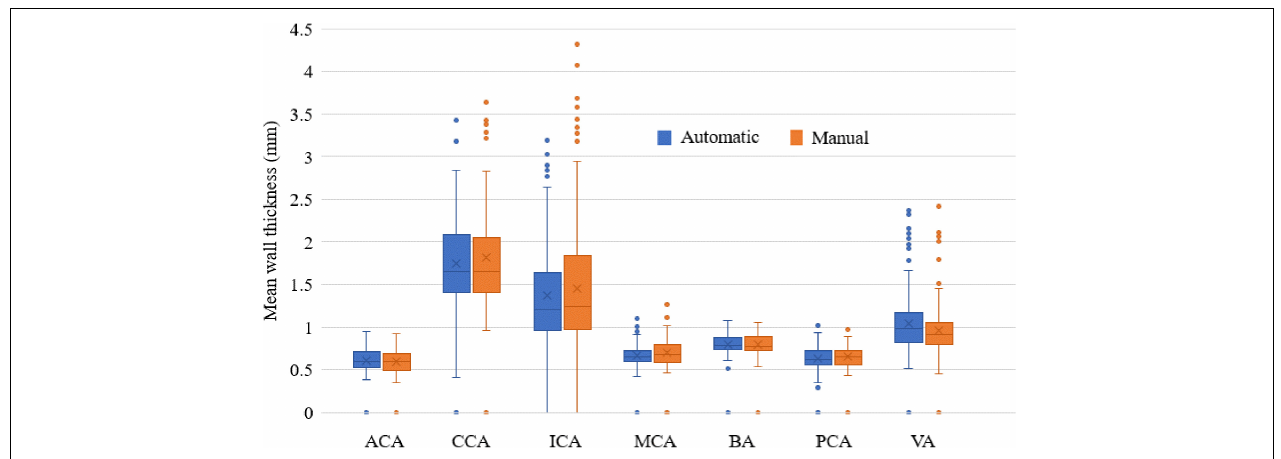
FIGURE 8 | The mean wall thickness of seven arterial segments. Boxplot shows the median with 25th and 75th percentiles. The “ × ” symbol points the mean and “o” shows the outliers.